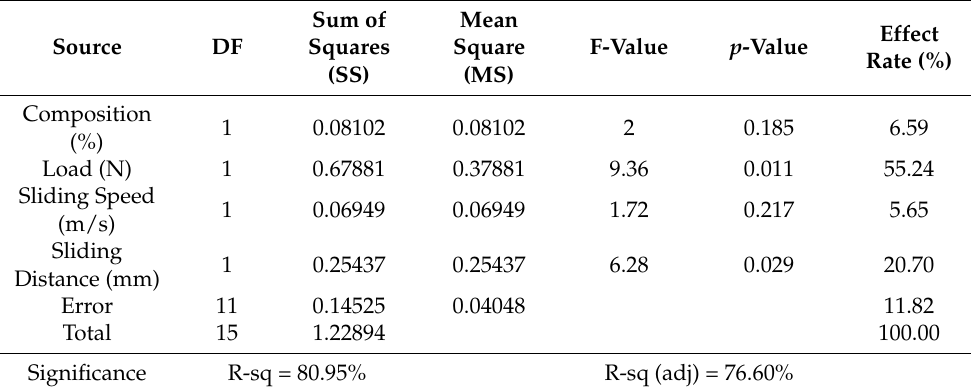
Figure 8. Fracture Surface Morphology for ( a ) MMT powder ( b ) SR1 ( c ) SR2 ( d ) SR3, and ( e ) SR4 composition. Table 5. ANOVA for Coefficient of